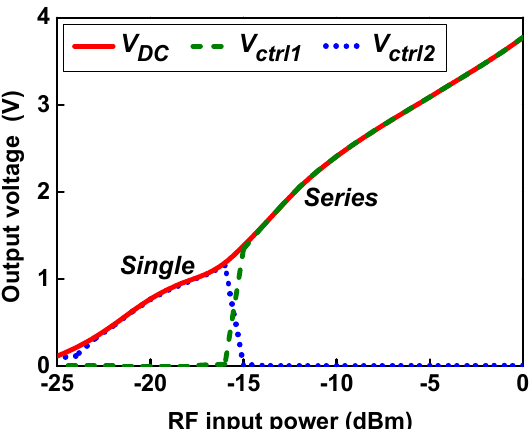
Figure 6. Output voltage and control voltages according to the RF input power.